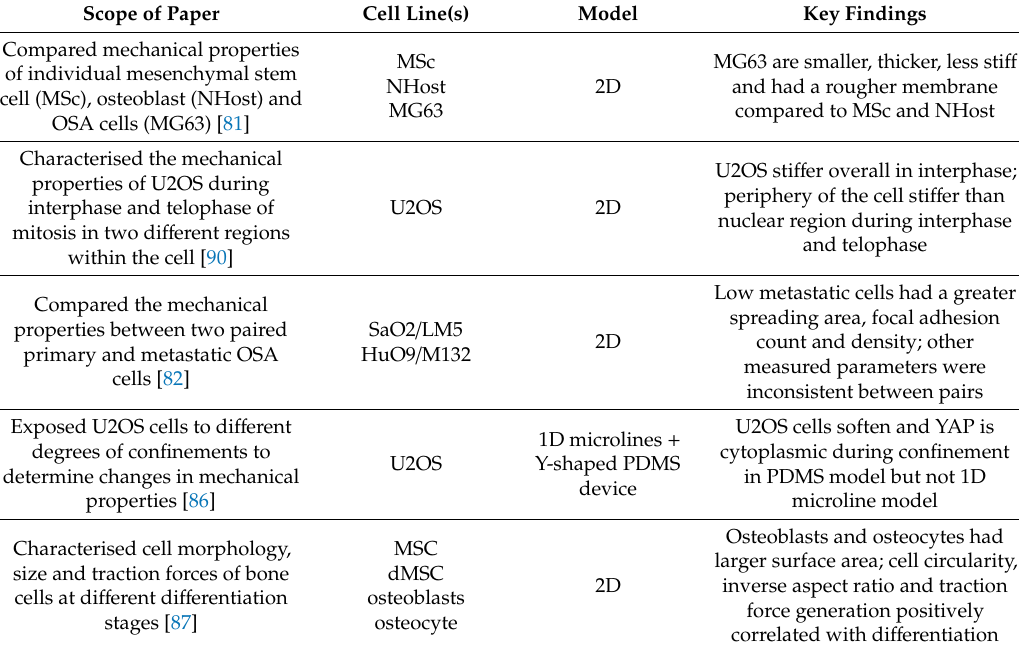
Table 1. Summary of literature included in this review that characterised the mechanical properties of normal bone and osteosarcoma (OSA)